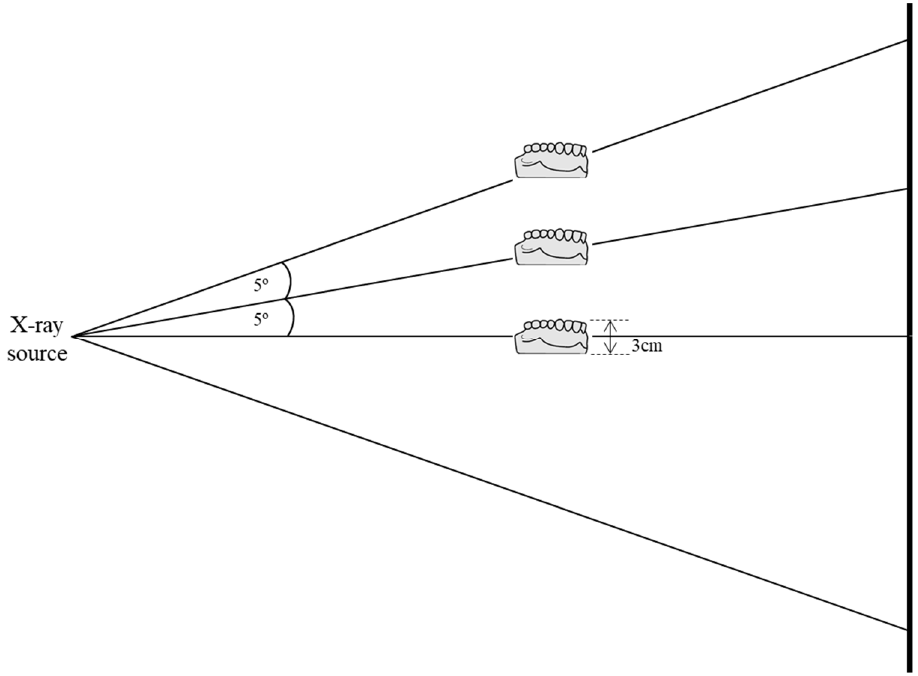
Figure 3. The cone-beam angles adopted in the micro-CT scan. The cone-beam angle is the vertical angle of the ray passing through the center of the object.